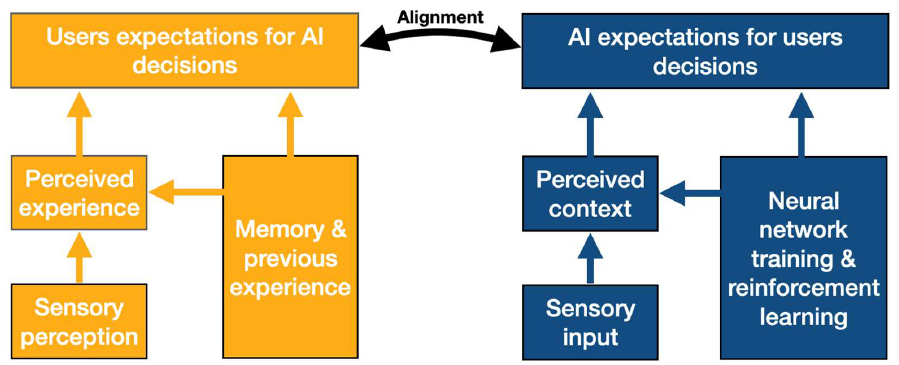
Figure 2. The Decision Perception Model elucidates the process by which both human and artificial intelligences form their expectations regarding the decisions made by the other party. Elaborated from [10].